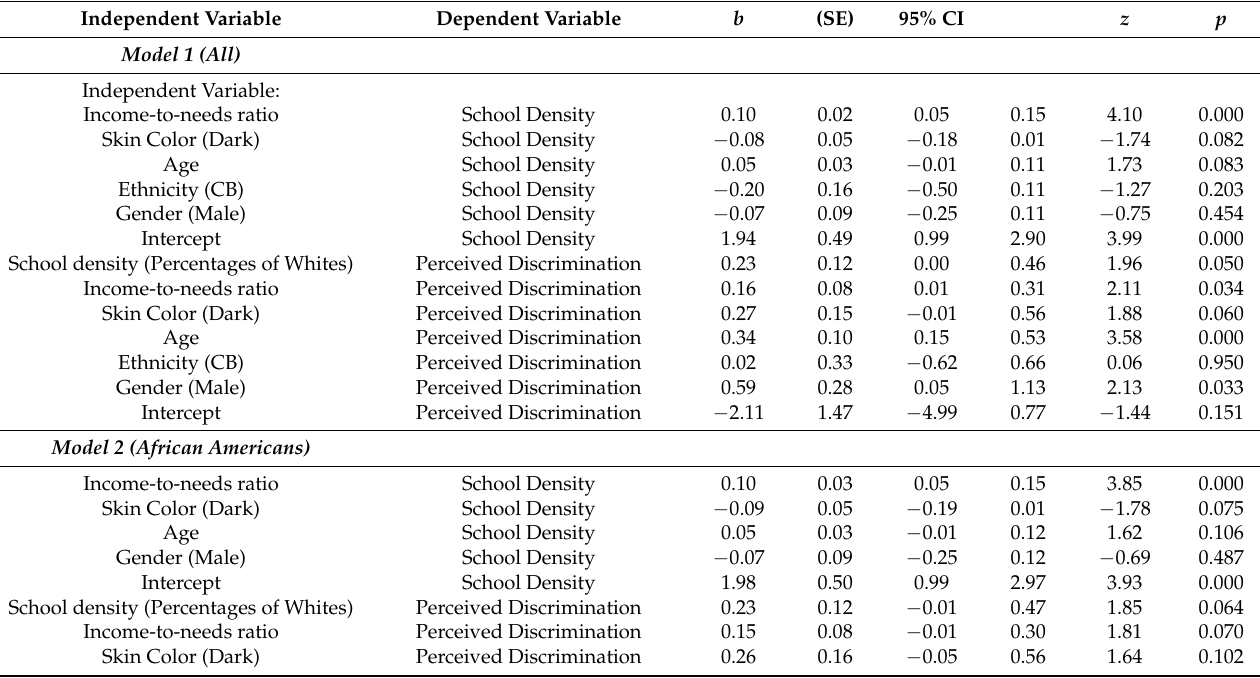
Table 2. Path coefficients for Model 1 to Model 3 in the pooled sample, African American, and Caribbean Black